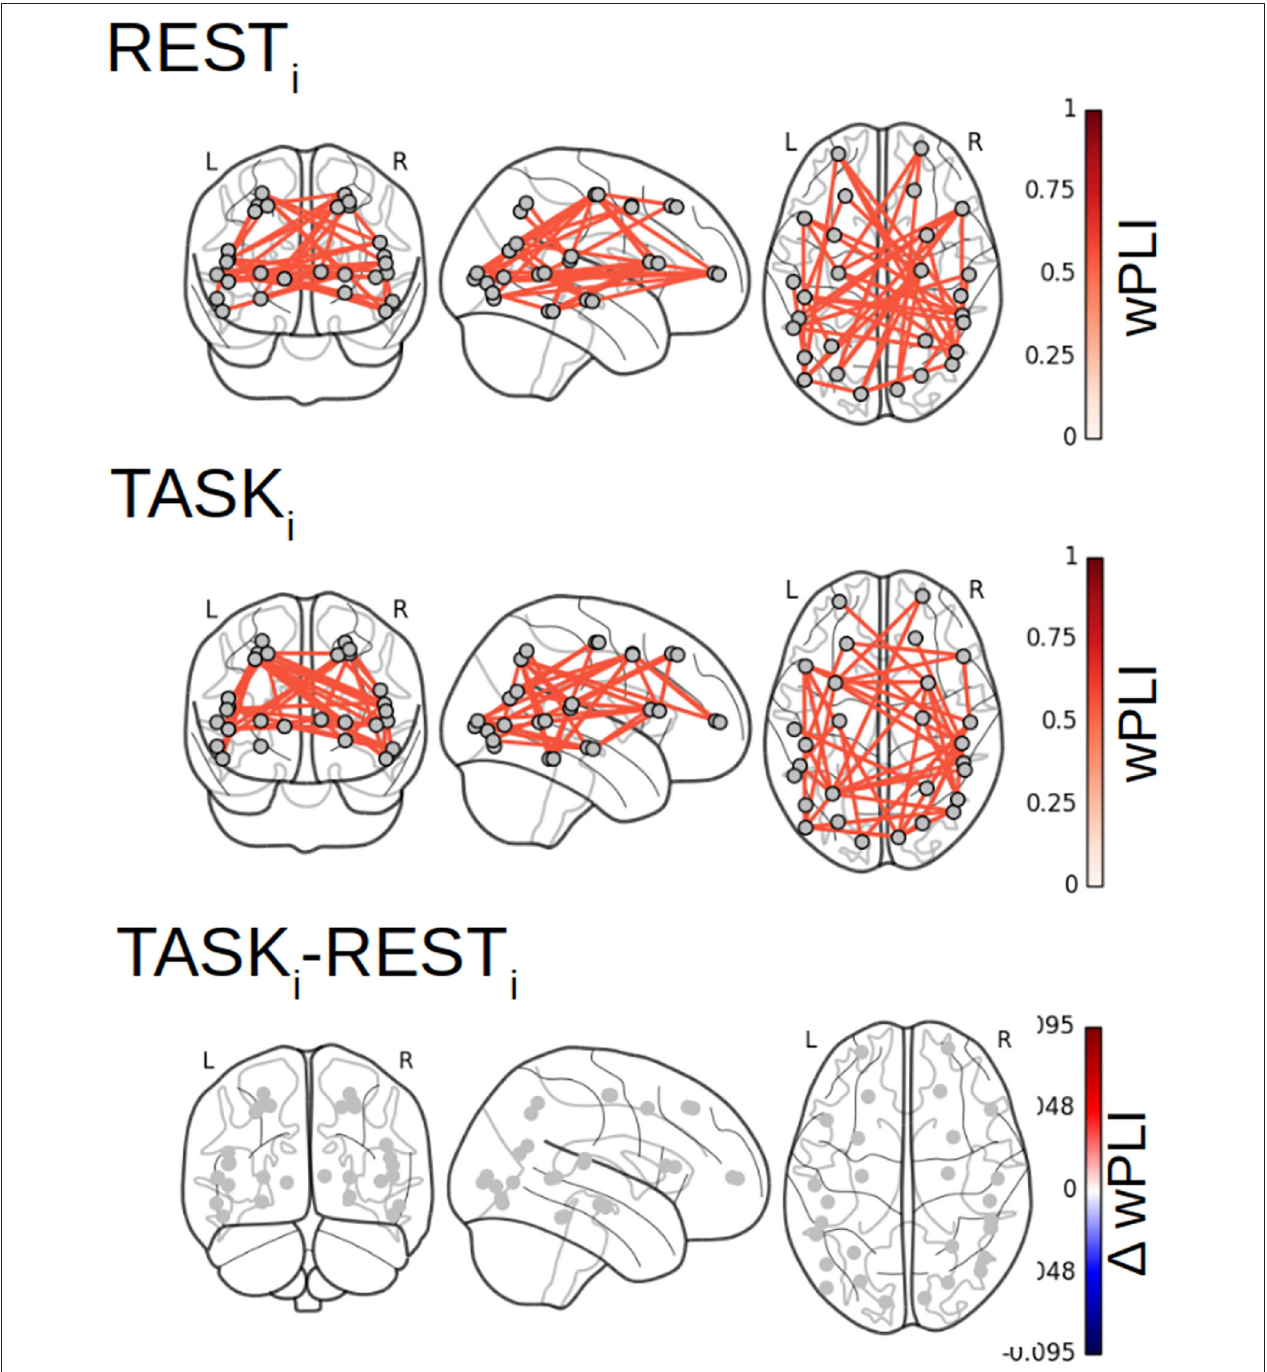
FIGURE 12 | Fourier-based wPLI estimator in the scale-free regime. No significant difference between F-wPLI TASK